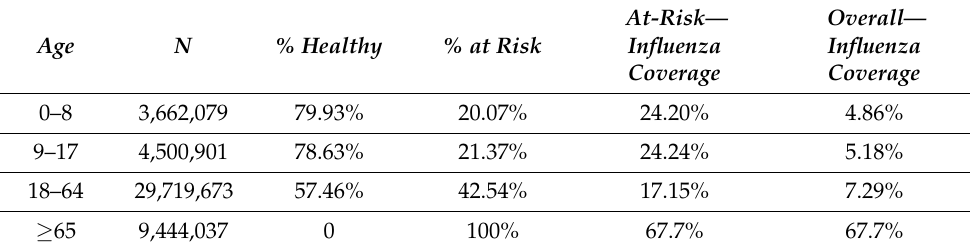
Table 2. Summary of Spanish population